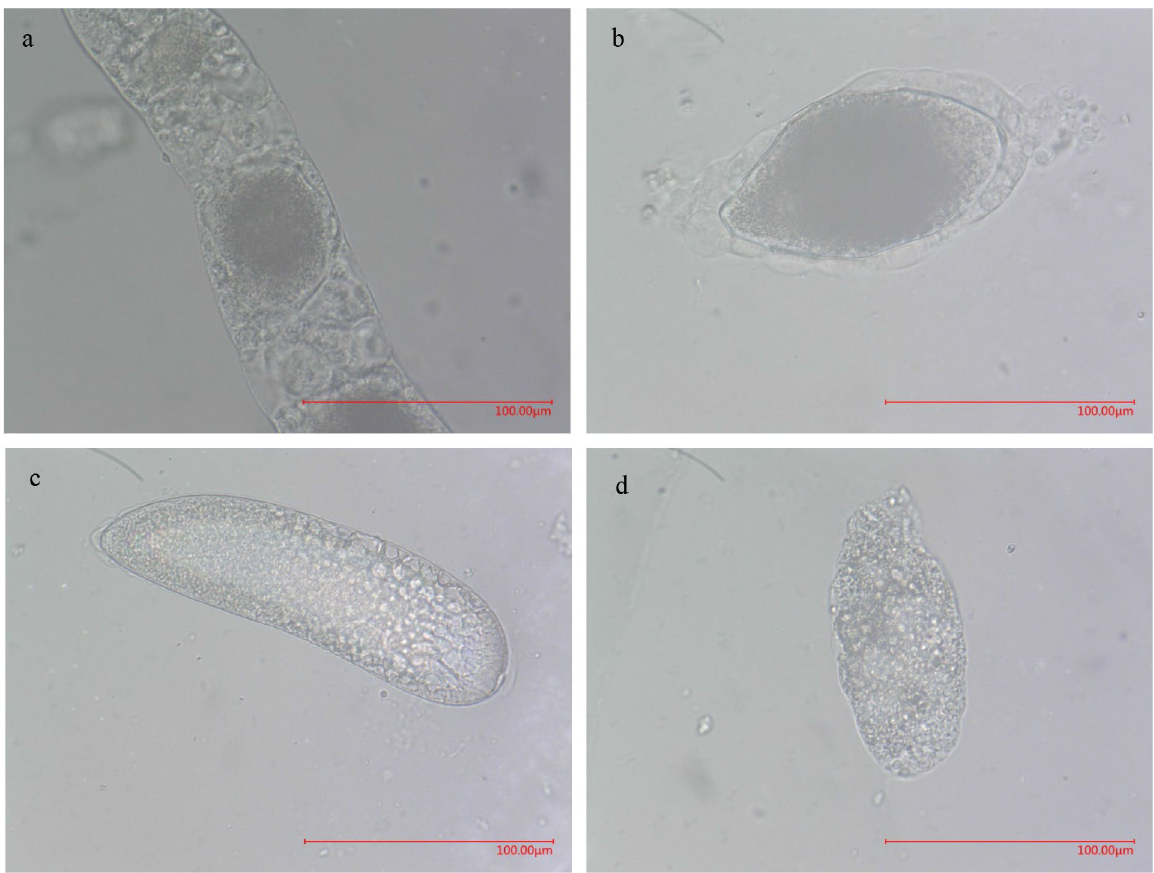
Figure 1. Four egg stages of C. japonicas. ( a ) Egg I; ( b ) egg II; ( c ) egg III; ( d ) egg